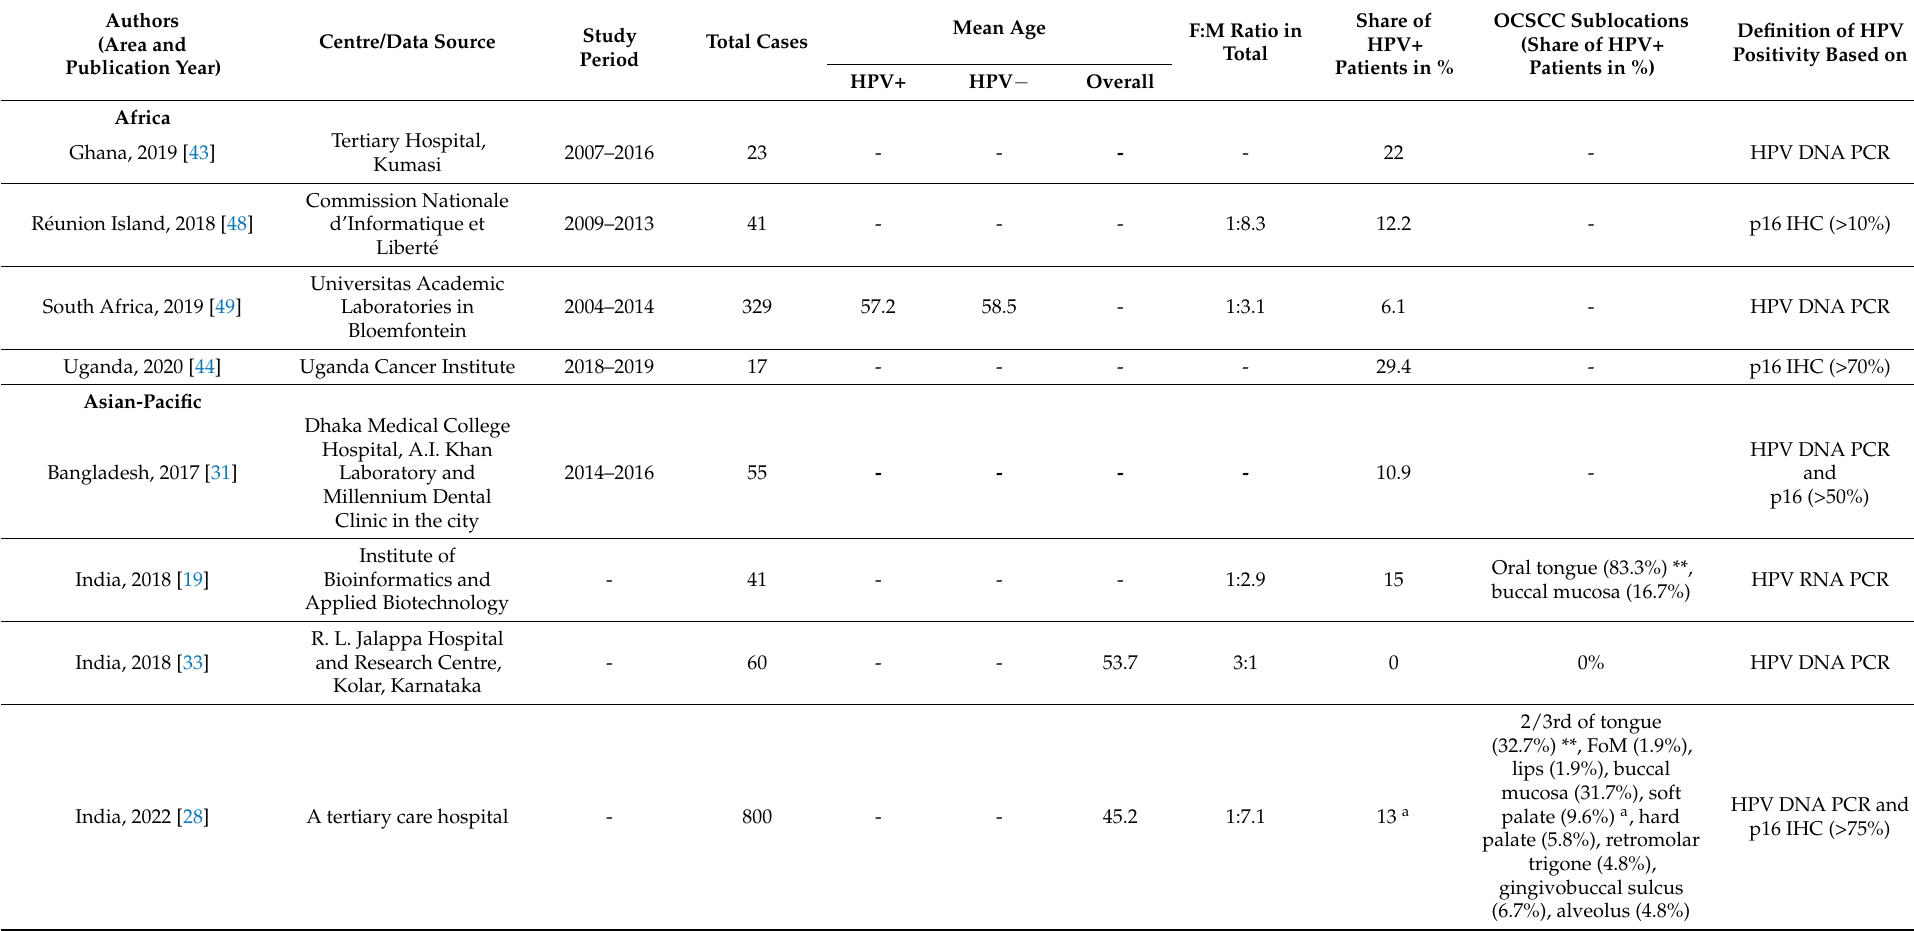
Table 1. HPV-positivity in OCSCC among patients